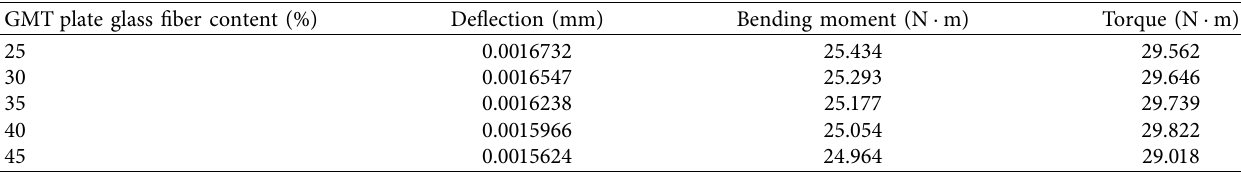
Table 2: Deflection and internal force values for different glass fiber contents.